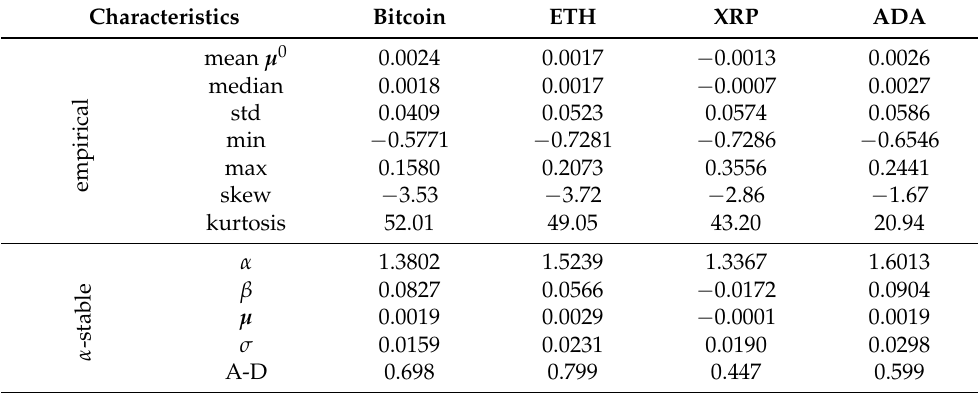
Table 5. Marginal characteristics of cryptocurrency returns.